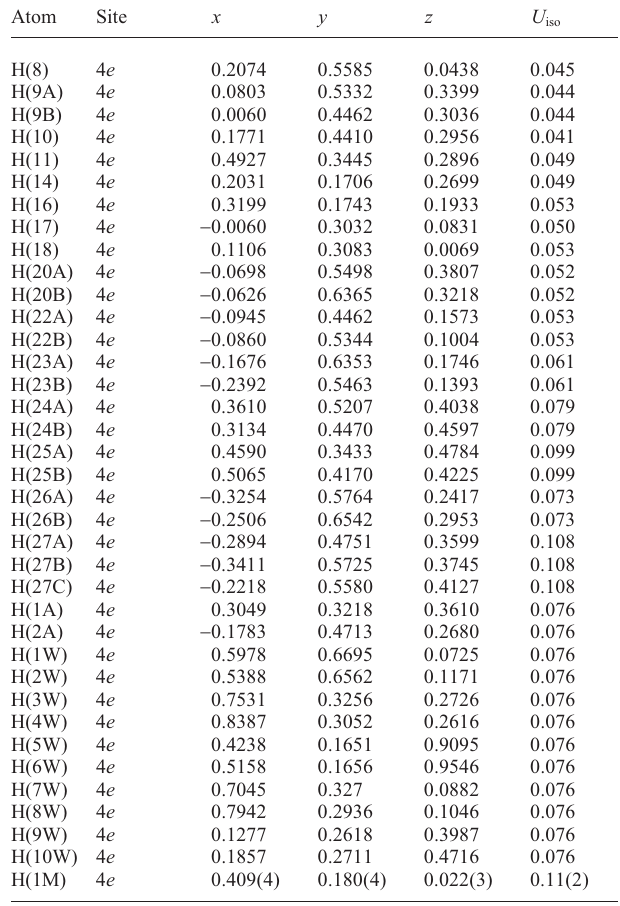
Table 2. Atomic coordinates and displacement parameters (in Å 2 )